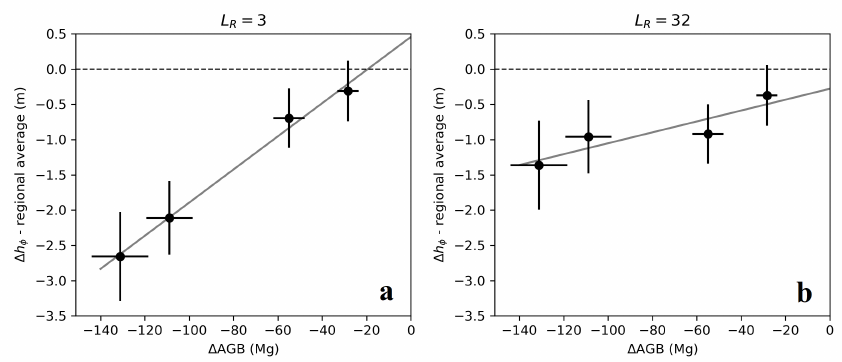
Figure 7. Relative h φ change between pre-logging and post-logging TDX acquisitions for the four 1 ha logging plots, plotted against field measured ∆ AGB. Multilooking was set to 3 × 3 ( a ) and 32 × 32 ( b ). Linear fits are shown in